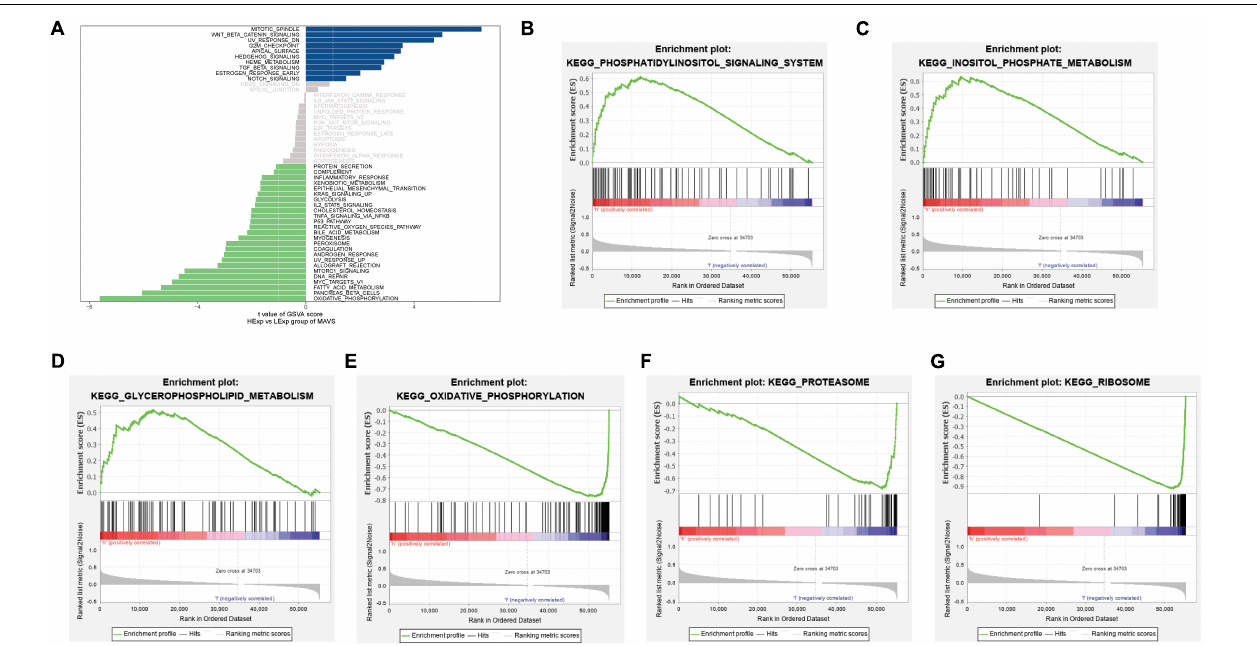
FIGURE 3 | Significant MAVS-related biological pathways in OC obtained by GSEA and GSVA. (A) Significant MAVS-related biological pathways in OC obtained by GSVA. (B–D) Top three oncological signatures significantly enriched in the MAVS positive expression group identified by GSEA analysis. (E–G) Top three oncological signatures significantly enriched in the MAVS negative expression group identified by GSEA